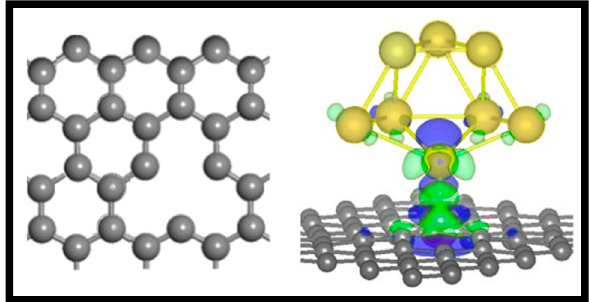
Figure 3. Au 8 cluster adsorbed on defective graphene. Left: Single vacancy in graphene substrate. Right: The chemisorption of Au 8 on defective graphene, the iso-surface of charge redistribution is imposed. Color Scheme: C in grey, Au in yellow, charge accumulation (depletion) in green (blue).